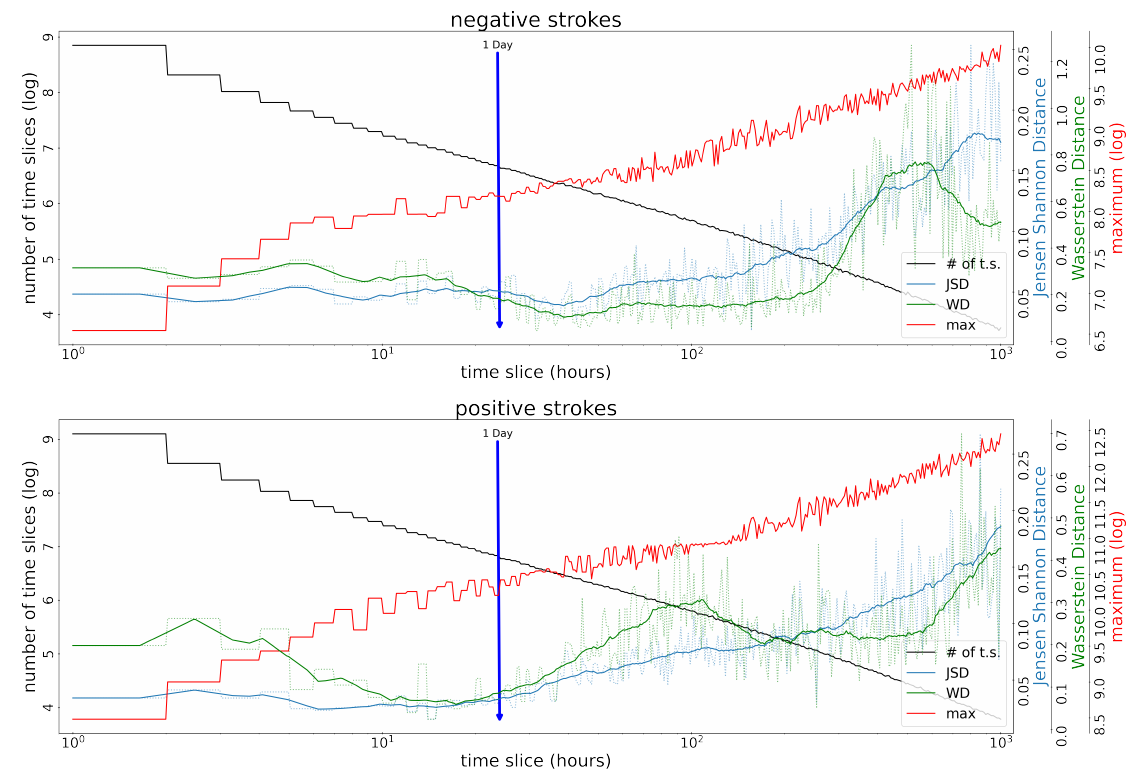
Figure 4. The choice of the size of the time slice. In these figures, which correspond to negative ( upper panel) and positive ( lower panel) strokes in the 2016–2020 time window, the horizontal axis is the size of the time slices in hours. In the vertical axis, the black line shows the number of time slices, the red line shows the maximum value of the dataset, and the solid blue and green curves represent the smoothed Jensen–Shannon distance (JSD) and Wasserstein distance (WD), respectively, where as dotted lines show actual